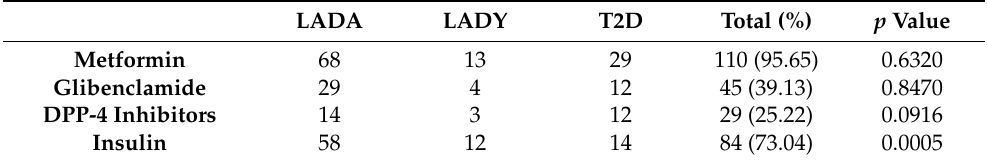
Table 2. Antidiabetic agents used by